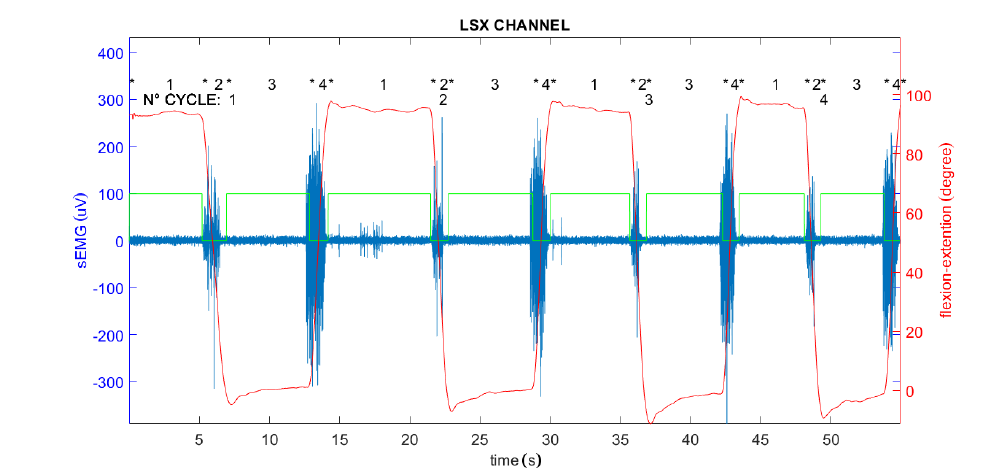
Figure 4. Graphic representation of the segmentation used to obtain the full-flexion phases of the same length. Only one channel is shown, but it is the same for all the other channels. In Step 1 and Step 2, the phases are depicted with the same length for simplicity, but they are not perfectly equal, while in Step 3, they are the same length. S = standing, F = flexion, FF = full flexion, E = extension, FF’ = new full